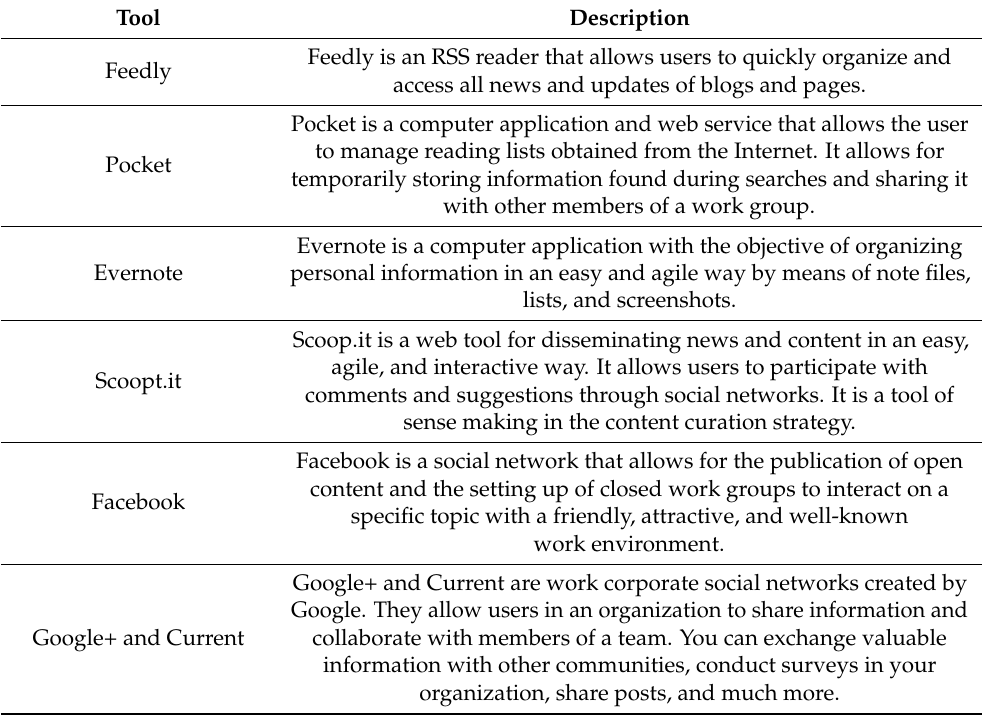
Table 3. Description of the recommended digital tools for content